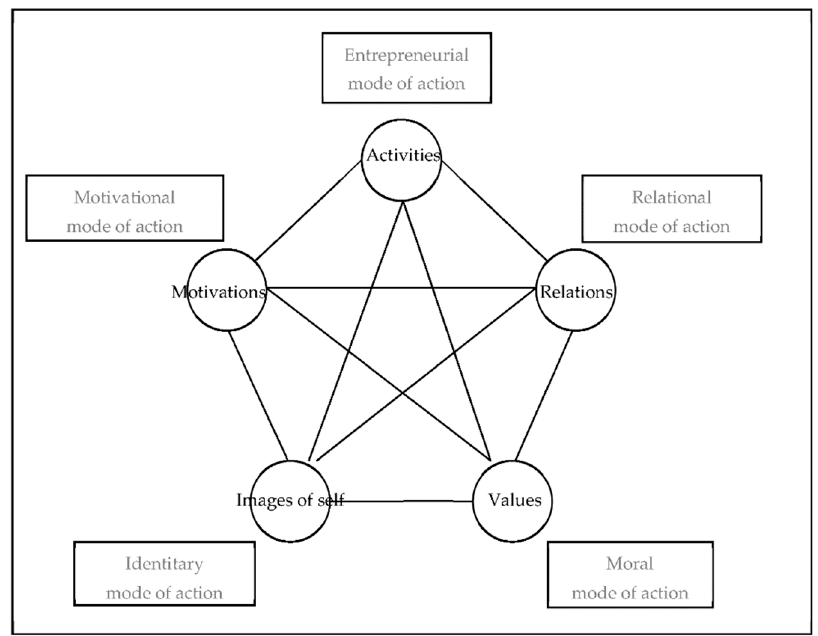
Figure 1. Transactional horizons and modes of action.